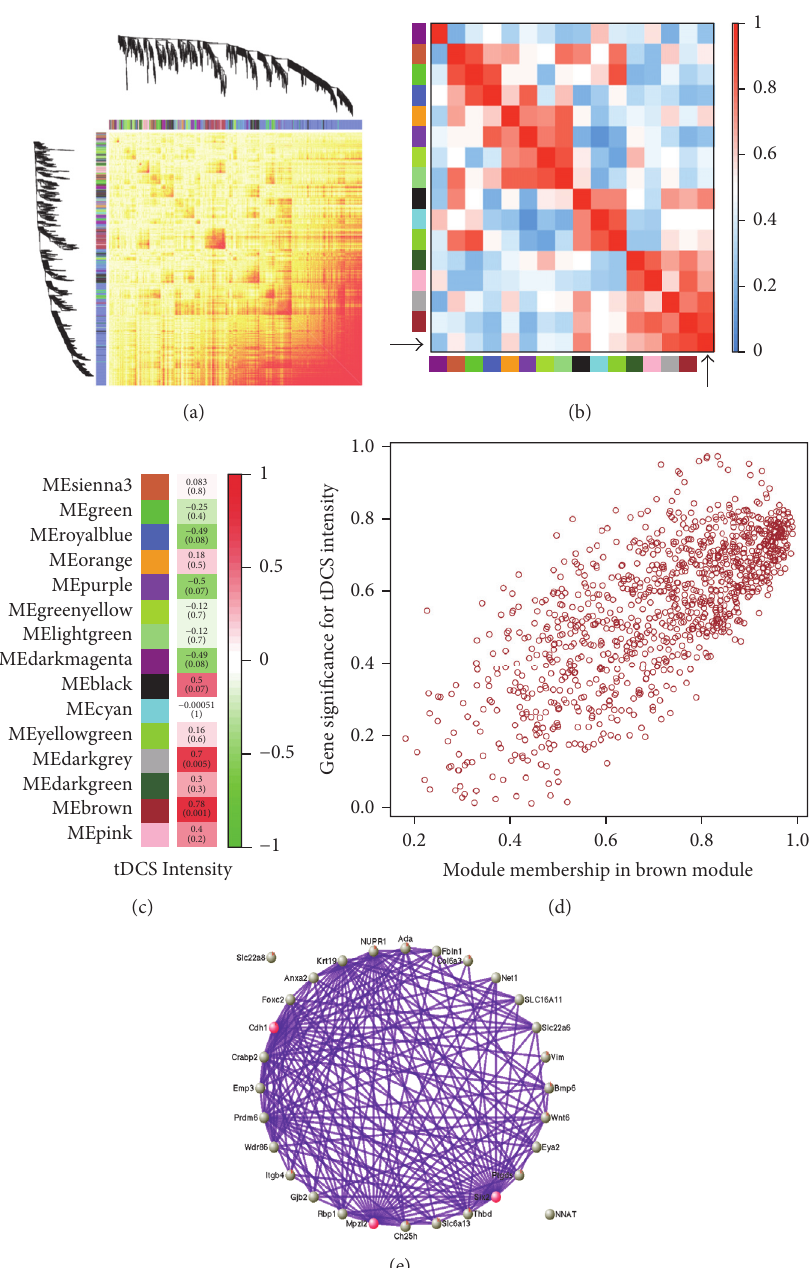
Figure 6: Weighted Gene Coexpression Network Analysis (WGCNA). (a) Network heatmap plot. Each branch in the hierarchical clustering dendrograms corresponds to each of 15 modules determined by the WGCNA. The color bars between the dendrograms and the heatmap plot represent the color-coded eigengene-based connectivity. Progressively more red color indicates highly interconnected genes in each module. (b) Heatmap plot of the adjacencies in the eigengene network including the trait tDCS current intensities. Each row and column in the heatmap indicate one module eigengene and the last row and column represent the trait tDCS current intensities. Negative and positive correlation are represented by green and red colors, respectively, as shown on the indicator (range: 0.0–1.0). (c) Module-trait (tDCS current intensity) relationship. Each row corresponds to a module eigengene, and each cell contains the corresponding correlation (top) and 𝑝 value (bottom in parentheses) calculated by the WGCNA package. (d) A scatterplot of gene significance (GS) for tDCS intensity versus module membership (MM) in the brown module. A highly significant correlation between GS and MM in the brown module (correlation = 0.74; 𝑝 value = 8.2𝑒 −186 ) was detected. (e) The network connections among the most connected genes in the brown module, generated by the VisANT software(version5.5).Theplotshowsnetworkconnectionswhosetopologicaloverlapisabovethethresholdof0.35,andthered-coloredgenes are the top 3 genes that have the greater number of